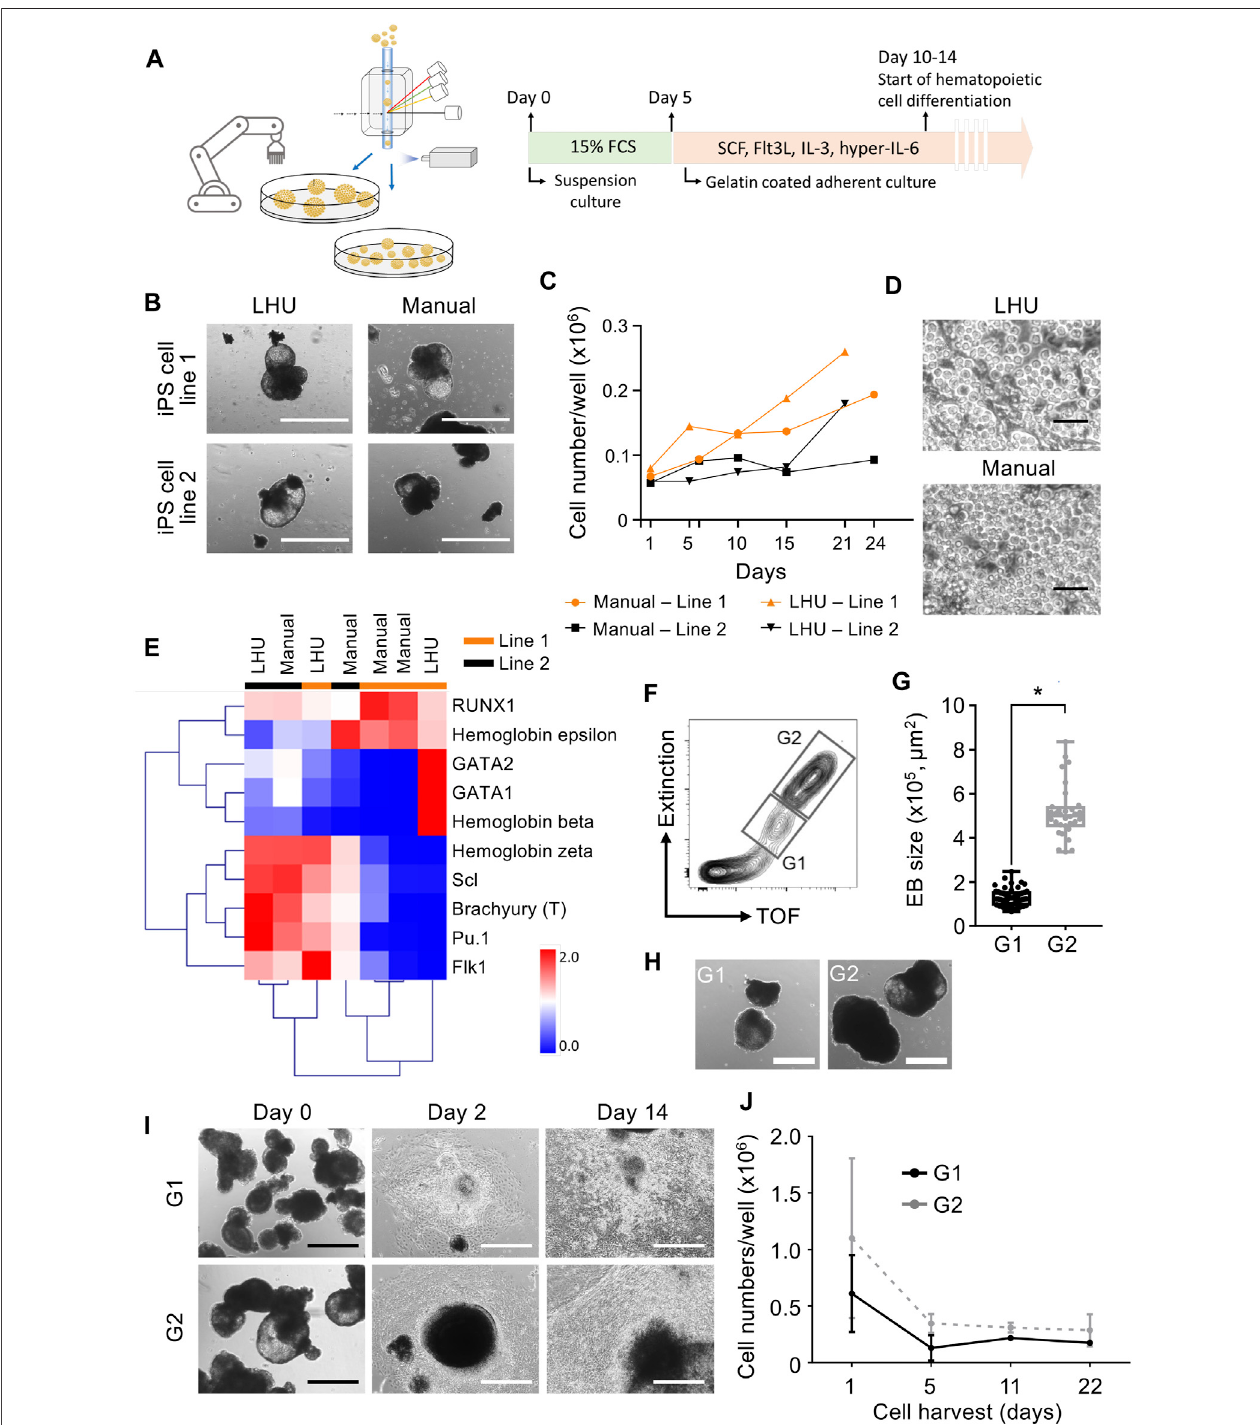
FIGURE 4 | Automated generation and sorting of iPS cell-derived embryonic bodies (EB) for hematopoietic differentiation. (A) Schematic representation of automated iPS cell hematopoietic differentiation pipeline. In the automated platform, iPS cells are expanded and EB are generated. Size based selection of EB is performedwiththecellclustersorter.EBformationisperformedwithaninitialsuspensionculturestepin15%FCSsupplementedmesoderminducingmedium,followed by an adherent culture step in hematopoietic supporting medium supplemented with SCF, Flt3L, IL-3 and hyper-IL-6. (B) Representative images of EB generated manuallyor by automation with the LHU. Scale bar: 1,000 µm. (C,D) Production ofhematopoietic cells from EB generated manually ( n = 2) or by automation ( n = 2) with the LHU for two iPS cell lines (line 1 and line 2) (C) . Representative phase contrast microscopy images of suspension hematopoietic cells produced by EB generated